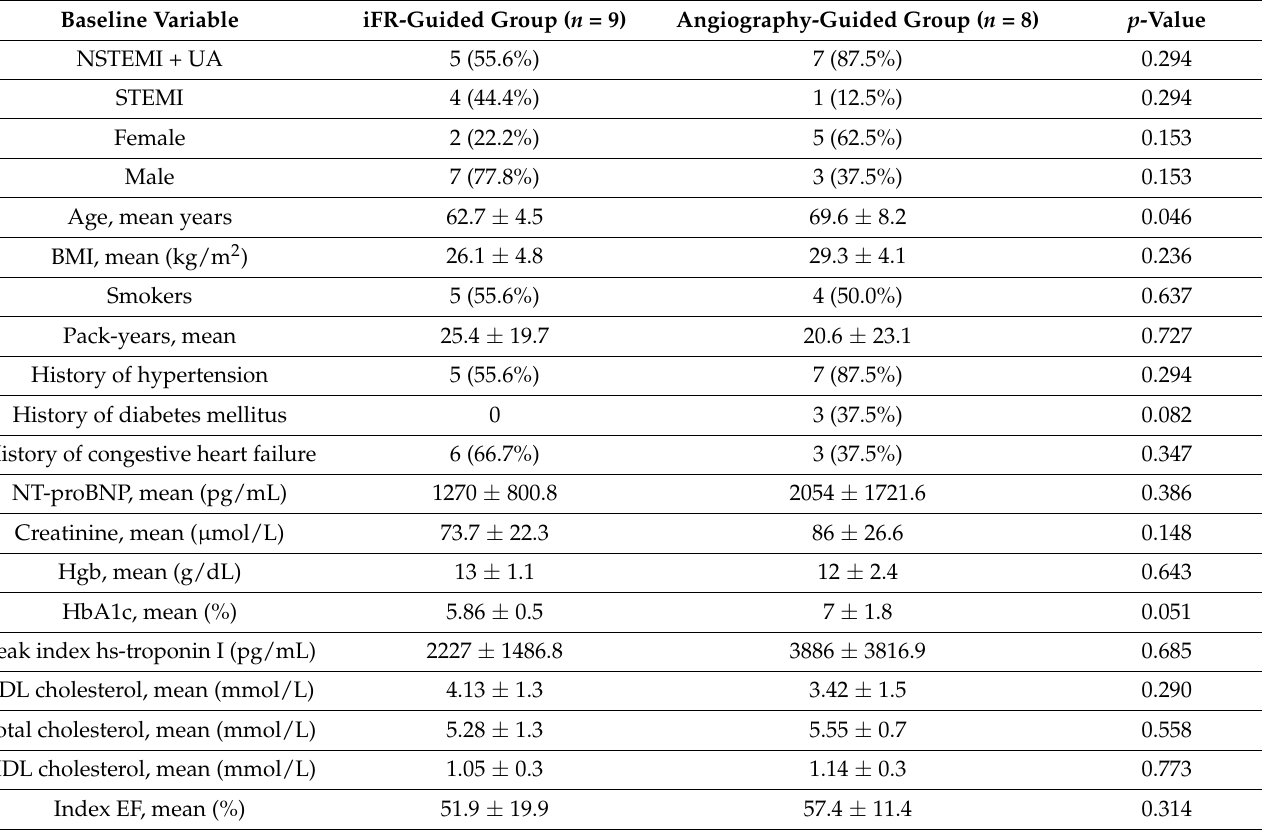
Table 1. Baseline characteristics of patients undergoing one-stage instantaneous wave-free ratio- guided and staged angiography-guided percutaneous coronary